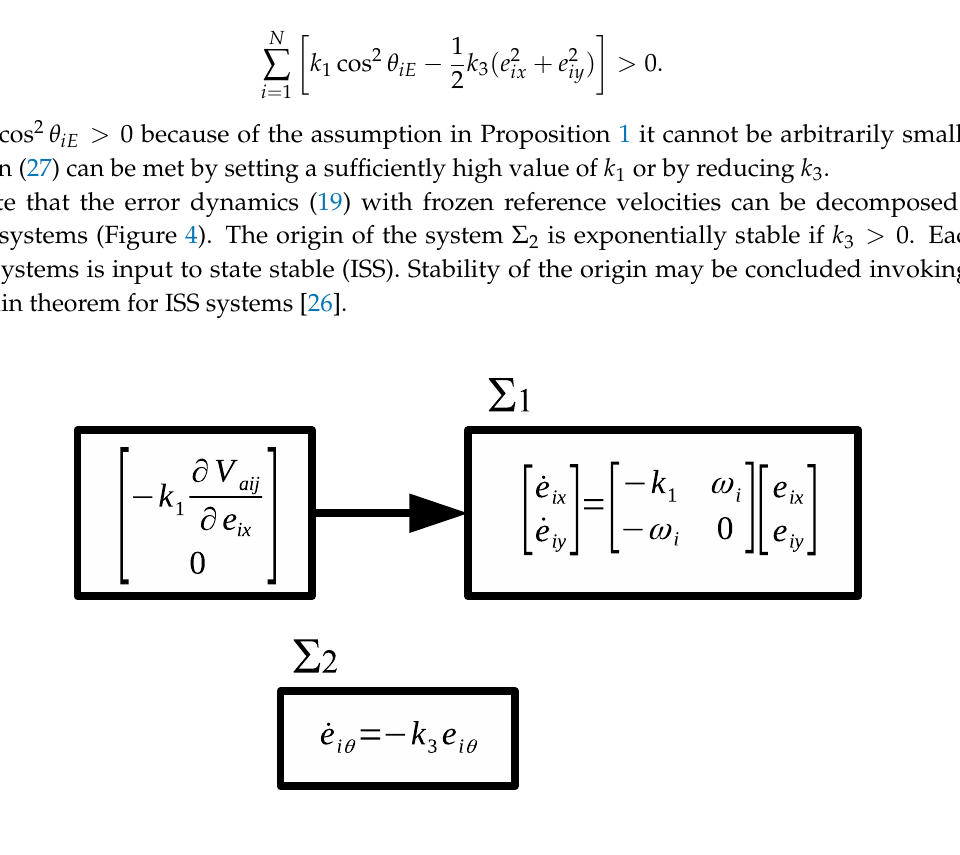
Figure 4. Diagram of the control system in the collision avoidance